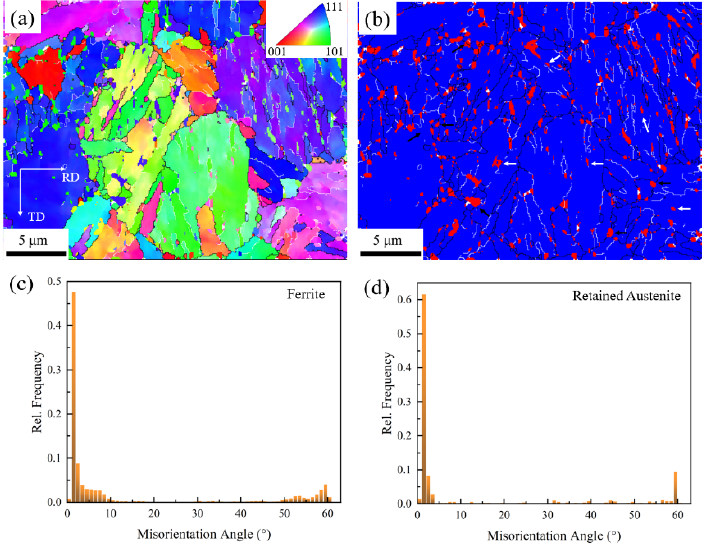
Figure 4. EBSD maps of the HSLA steel: ( a ) inverse pole figure (IPF) map; ( b ) phase map of ferrite (blue) and retained austenite (red); ( c ) correlated misorientation angle distribution between ferrite variants; and ( d ) correlated misorientation angle distribution between retained austenite.